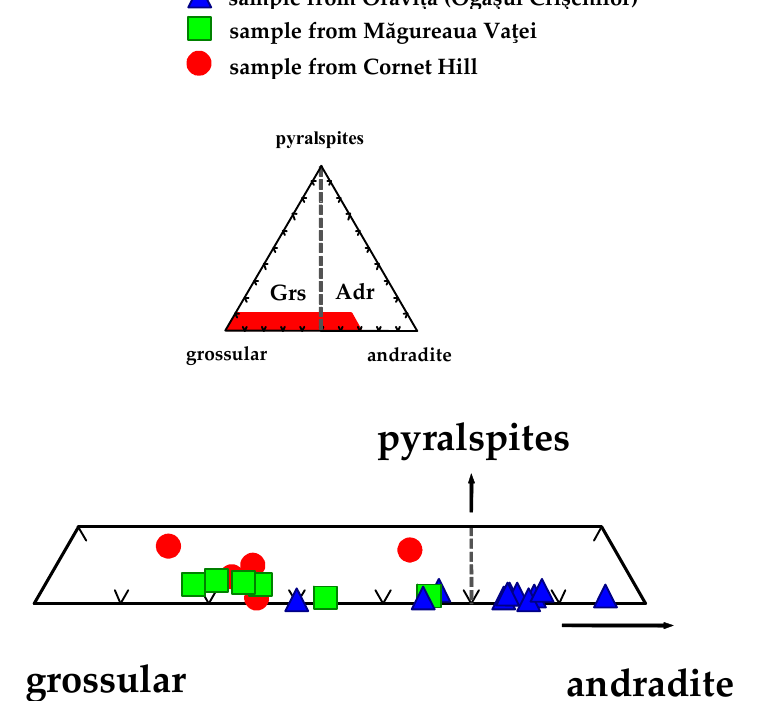
Figure 6. Ternary diagram showing the position of the calcic garnets in equilibrium with gehlenite in the grossular–andradite–pyralspites solid solution, particularized for the high-temperature skarns in Romania. Data from Cornet Hill as given by [15] and from Oravi ţ a as given by [17].